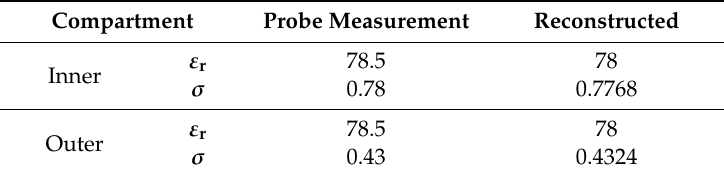
Figure 7. ( a – d ) indicate the measured permittivity and the reconstructed one by using the traditional method based on LHA (Helmholtz), the wave-equation-based finite-difference method (modified Finite-Difference (mFD)) and the proposed method, respectively. ( e – h ) indicate the measured conductivity and the reconstructed one by using the three methods, respectively. Table 2. Reconstructed EPs of the phantom (based on simulated data).